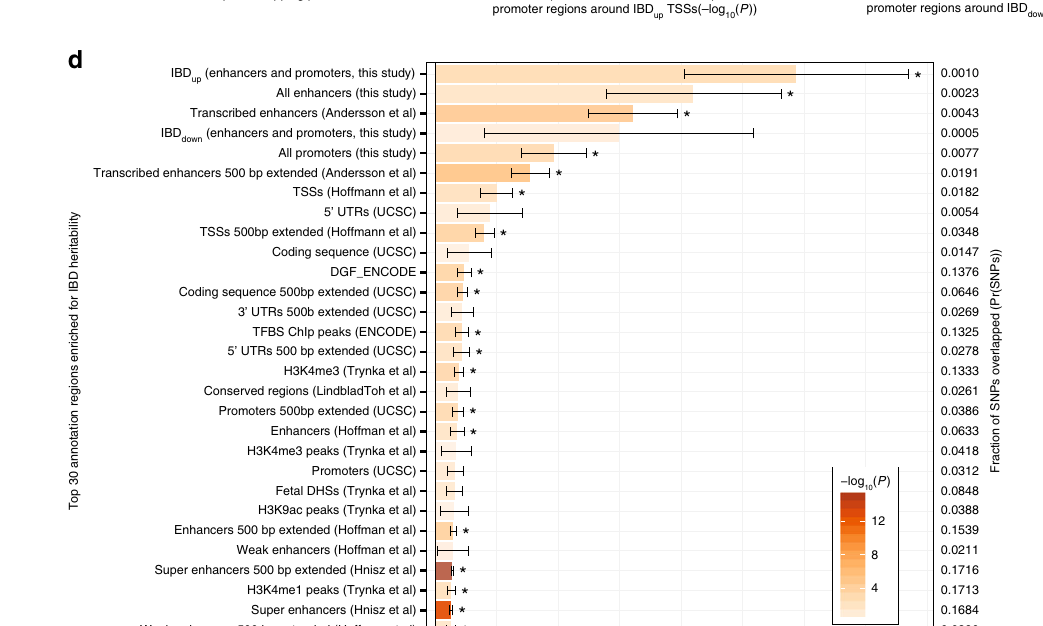
| DOI: 10.1038/s41467-018-03766-z |